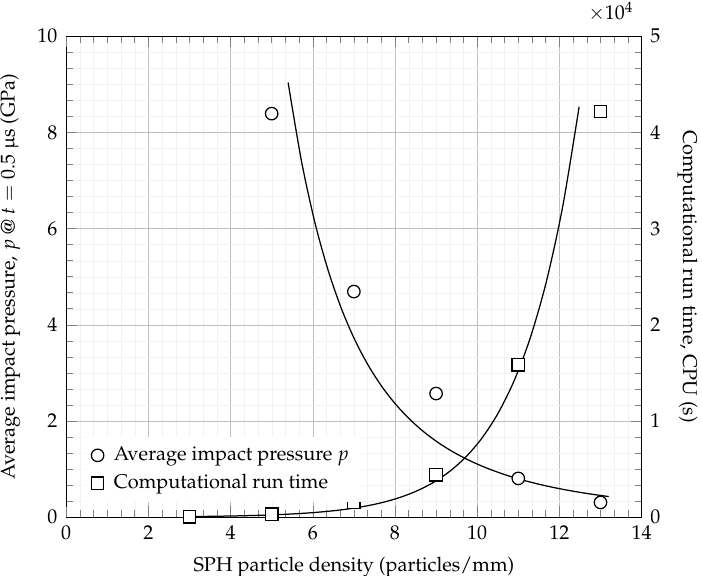
Figure 9. Average impact pressure p at time t = 0.5 µ s and computational run time (CPU) against the SPH particle density, with corresponding